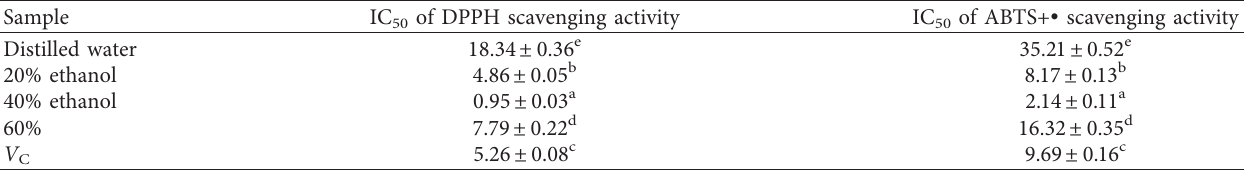
Table 1: The IC 50 of free radical scavenging capacity for BKBA ( μ g/mL).